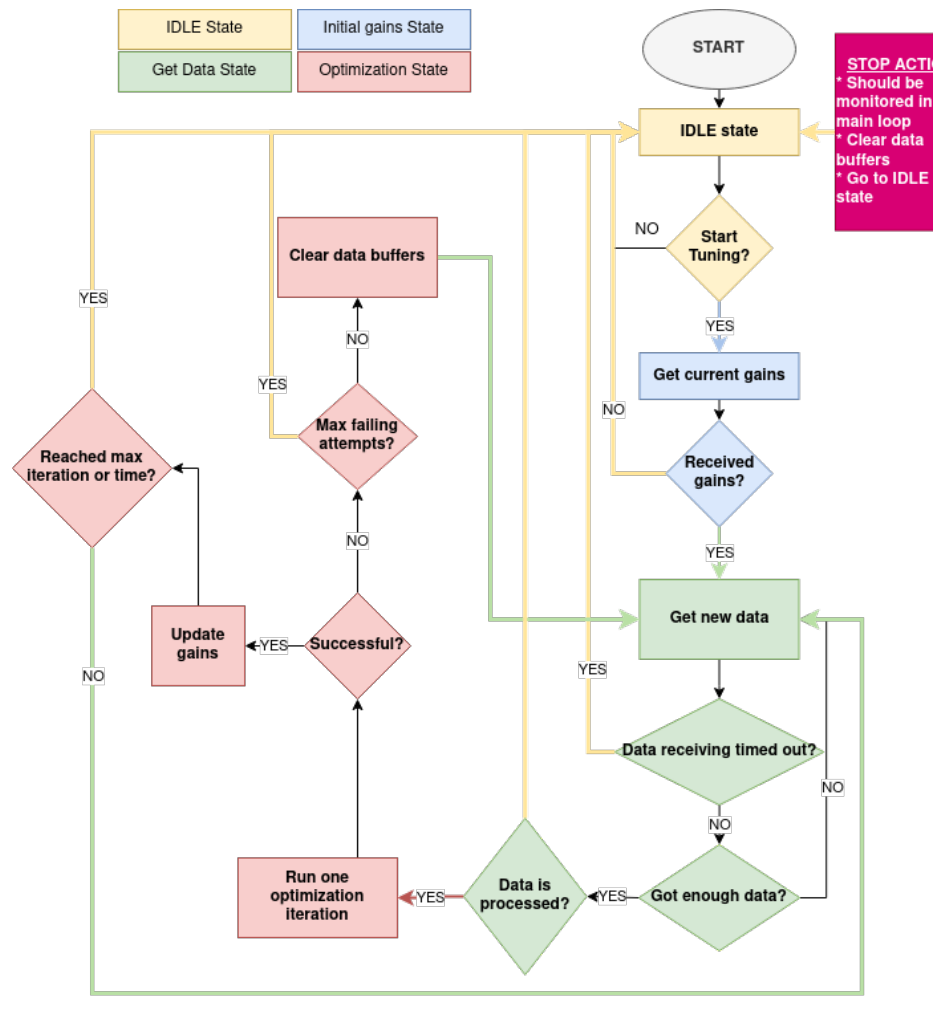
Figure 6. The auto-tuning state